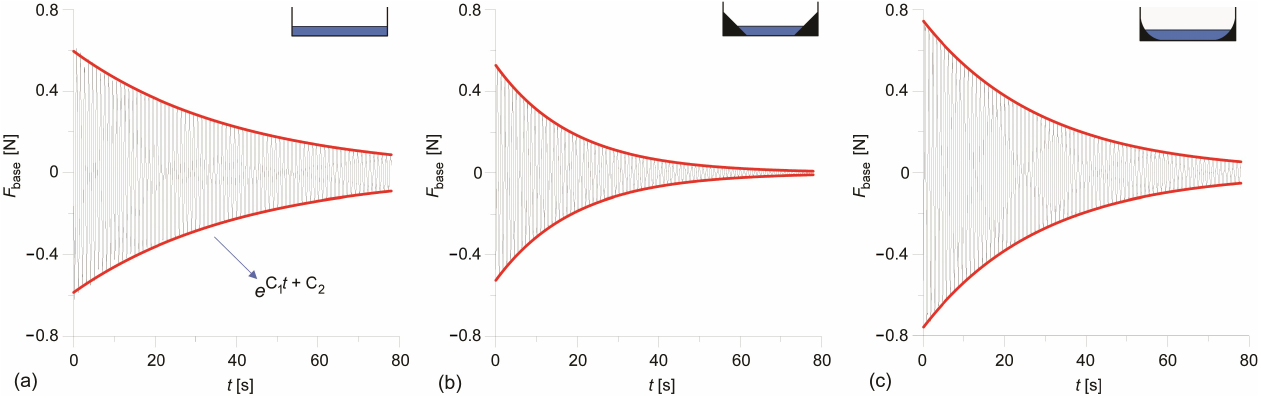
Figure 6. Base force time histories with the calculated enveloping exponential interpolating curves for different bottoming bases at h = 7